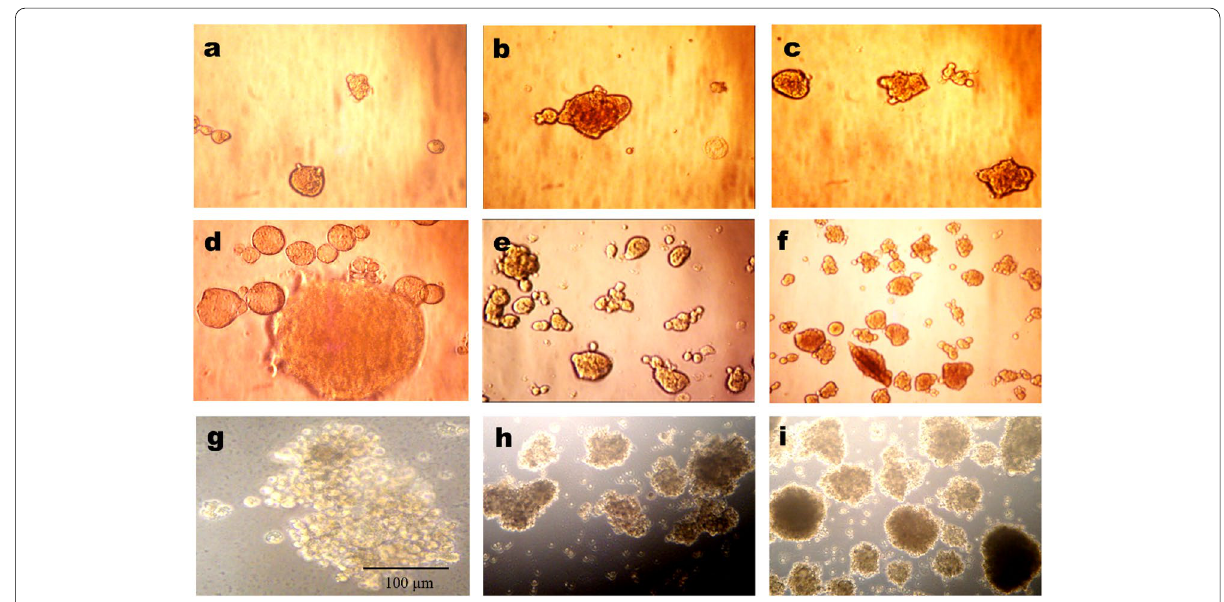
Fig. 2 Mammospheres formed from normal breast tissues, primary tumor tissues, and MCF-7 cell line